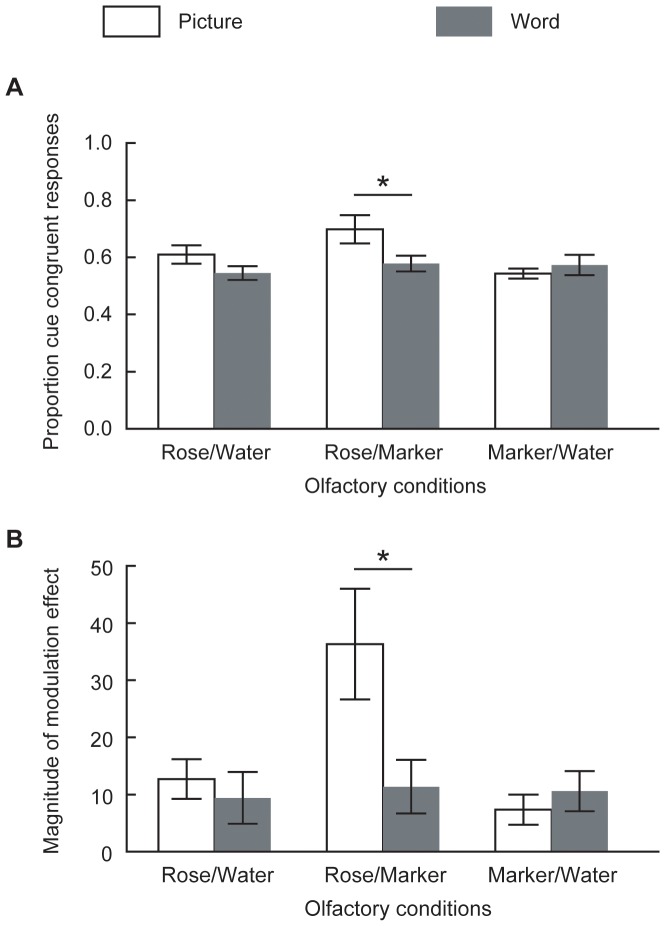
Visual perceptual versus semantic modulations of mononaral and binaral olfactory perceptions.Comparison between visual perceptual and semantic modulations of mononaral (rose/water, marker/water) and binaral (rose/marker) olfactory perception as reflected in (A) proportion of cue-congruent button responses reporting detecting the cue-congruent smell, and (B) magnitude of cue-induced perceptual alternations on the combined bipolar similarity scale. Compared with words, pictures significantly increased cue-congruent button responses and biased similarity ratings to the cue-congruent end under binaral but not mononaral settings. The proportion of cue-congruent olfactory responses was calculated as the number of cue-congruent button responses (e.g. smelling a rose smell in the presence of a rose picture or the word ‘rose’) divided by the total number of trials. The magnitude of modulation effect was calculated as the distance between the similarity scores on the combined scale in the presence of a rose cue vs. a marker cue. Error bars represent standard errors of the mean. *p<.05.